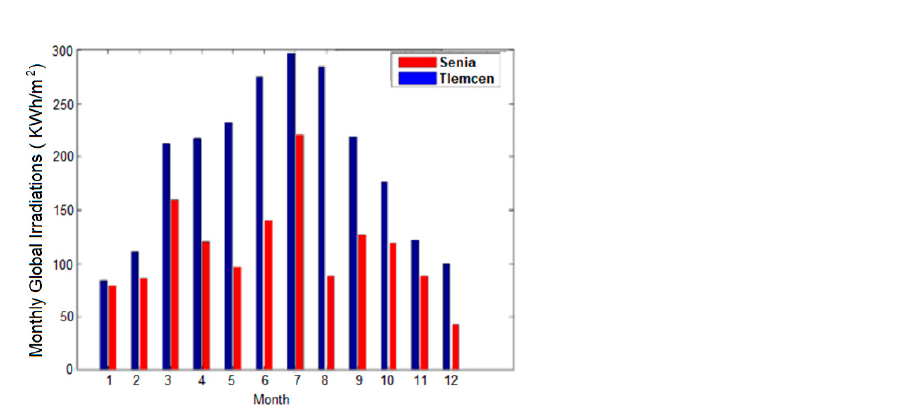
Figure 6. The distributions of the annual change of the monthly global solar irradiations measured on a horizontal plane for both sites.